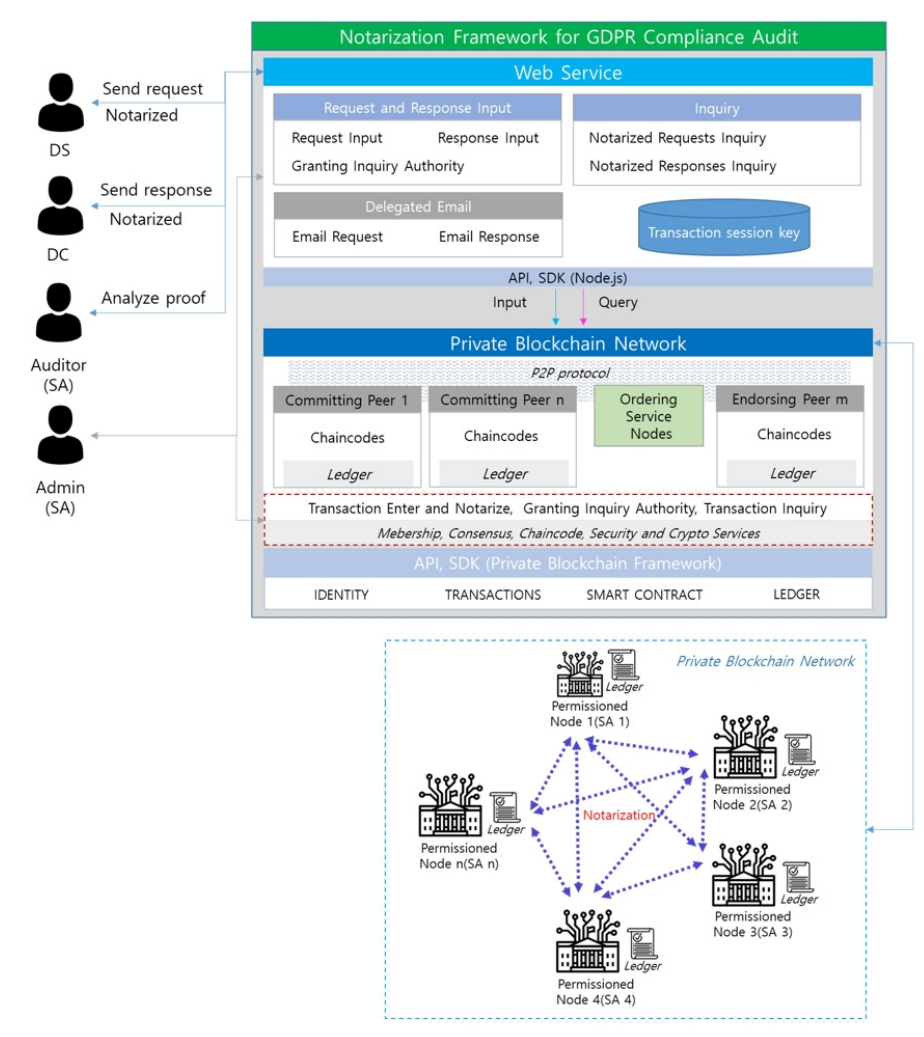
Figure 6. Notarization framework overview based on BC. All data derived from the process of requesting and responding to the processing of personal data between the DS and DC are stored in the BC ledger through a notarization system. SAs can conduct transparent and reliable GDPR compliance audits based on the notarized ledger through the notarization